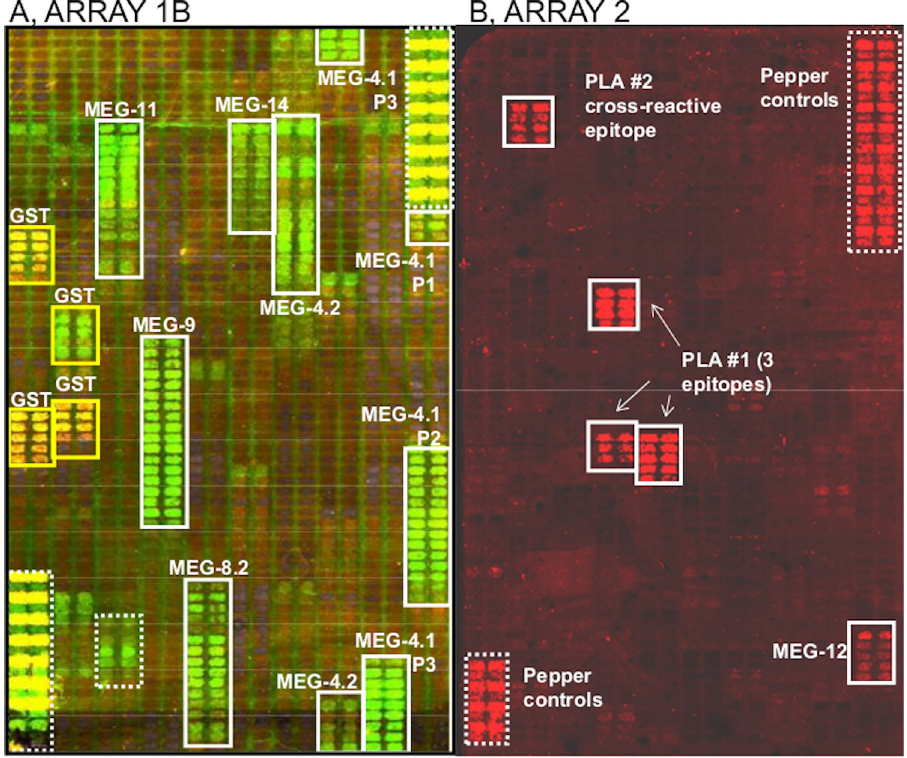
Fig 1. Screen grabs from the Agilent analyser showing the reactivity of positive control sera in annotated square boxes. The screen output is not a true representation of spectral emission lines but yellow/green in A corresponds to Cy3 at 570nm and red in B to Cy5 at 670nm. A, Reactivity of nine rat sera raised against defined peptide targets, applied at 1:1000 dilution, and mouse serum against recombinant Sj26GST, applied at 1:100 dilution, on Array 1b. The large boxes with dotted outline are the standard array controls supplied by PEPperPRINT. The small dotted box at bottom left delineates cells that reacted with the Cy3-goat anti-mouse prestain. All other cells were negative. B, Reactivity of four positive control mouse sera against peptides from MEG-12 and Phospholipase A #1 (PLA #1) applied at 1:2000 dilution, on Array 2, with Cy5 labelled secondary antibody. Antibody to MEG-12 had a relatively weak reactivity while the three anti-PLA1 sera detected epitopes of varying length and one (against PLA #1 peptide RGAPYDFRKSPDNK) also reacted with a related epitope in PLA #2.